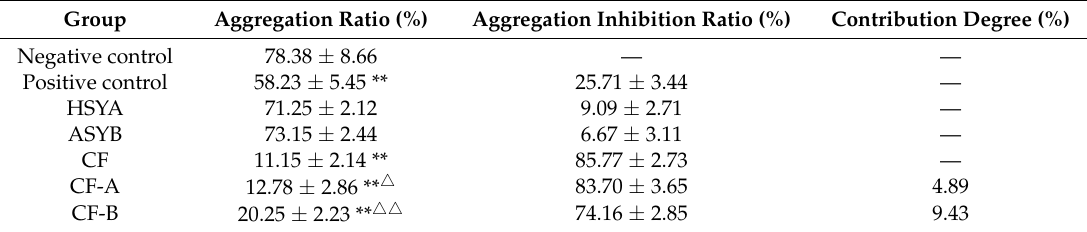
Table 2. Samples before and after knocking out the target component and knock-out constituents